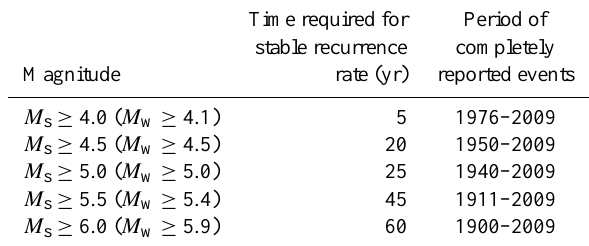
Table 1. Results of the completeness test for Greece (1900–2009). Time required for Period of stable recurrence